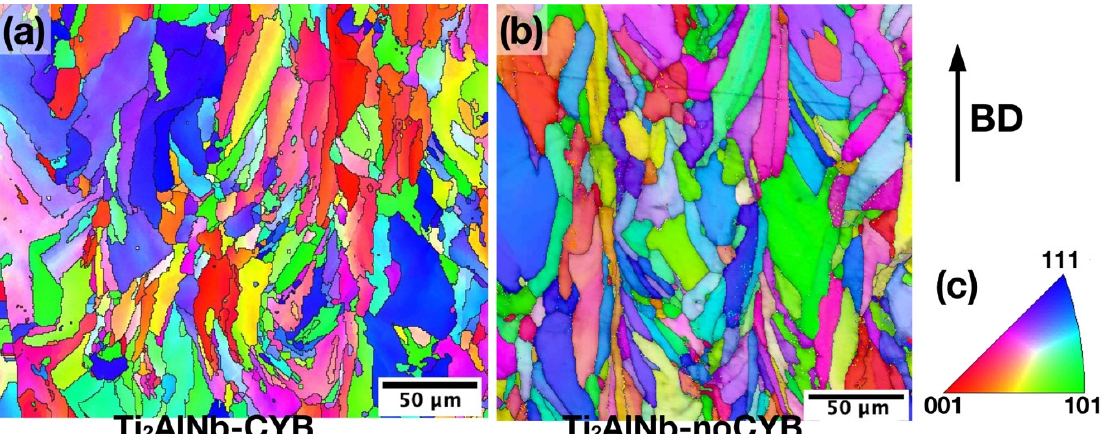
Figure 10. EBSD orientation maps along the BD of the samples fabricated at 300 °C preheating temperature from ( a ) the Ti 2 AlNb-CYB and ( b ) the Ti 2 AlNb-noCYB powders, ( c ) inverse pole figure of β -phase.